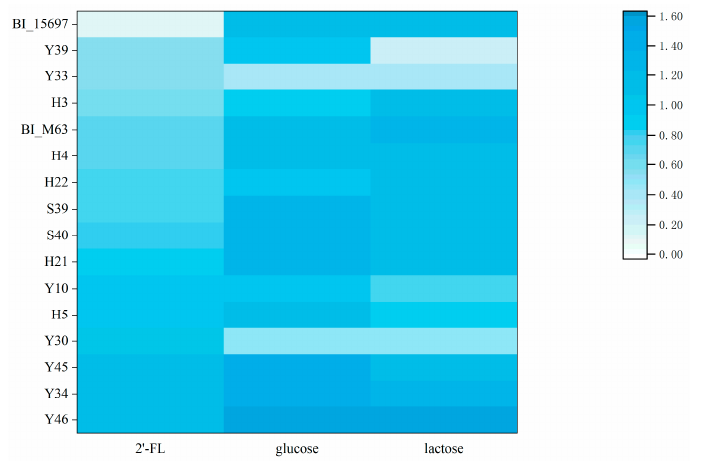
Figure 1. Maximum bacterial growth (change in optical density at 595 nm) in the presence of 1% glucose, lactose and 2 (cid:48) -fucosyllactose (2 (cid:48) -FL) during 48 h of glucose, lactose and 2 ′ -fucosyllactose (2 ′ -FL) during 48 h of incubation.